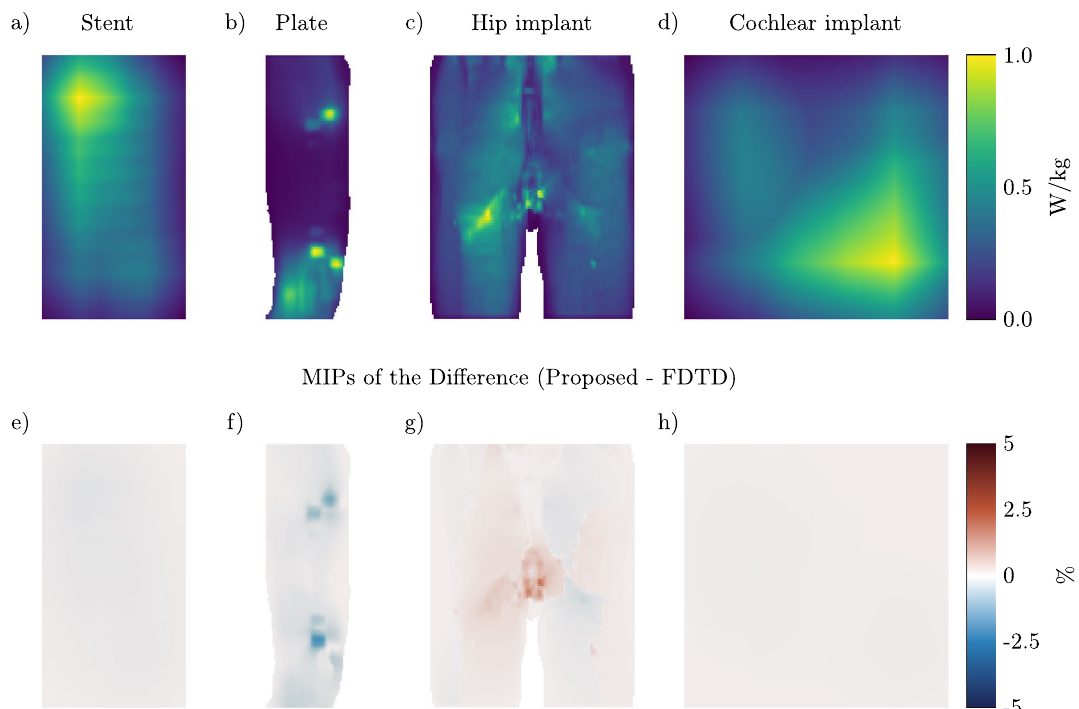
Figure 10. The MIPs of the 1 g averaged SAR obtained with the proposed method ( a till d ) and MIPs of the difference between the proposed method and the FDTD simulations ( e till h ). ( a ) For the stent. ( b ) For the plate with screws. ( c ) For the hip implant. ( d ) For the cochlear implant. ( e ) The MIP of the difference for the stent. ( f ), ( g ) and ( h ) The same for the plate with screws, hip implant, and the cochlear implant